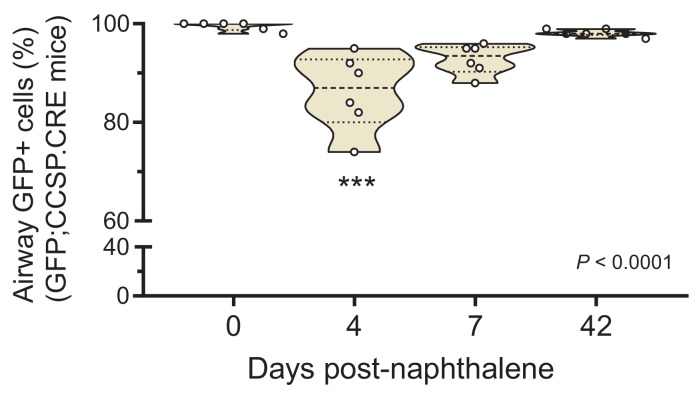
Airway epithelial cell ablation by naphthalene: data summary.Violin plot of percentage of GFP-labeled airway cells from experiment described in Figure 4—figure supplement 3 (n = 6 mice/time-point). P, overall probability, one-way ANOVA. ***: p<0.001 for the comparison with day zero, Bonferroni post-test.10.7554/eLife.45571.052Figure 4—figure supplement 4—source data 2.Quantification of GFP+ airway cells in GFP;CCSP.CRE mice after naphthalene treatment.